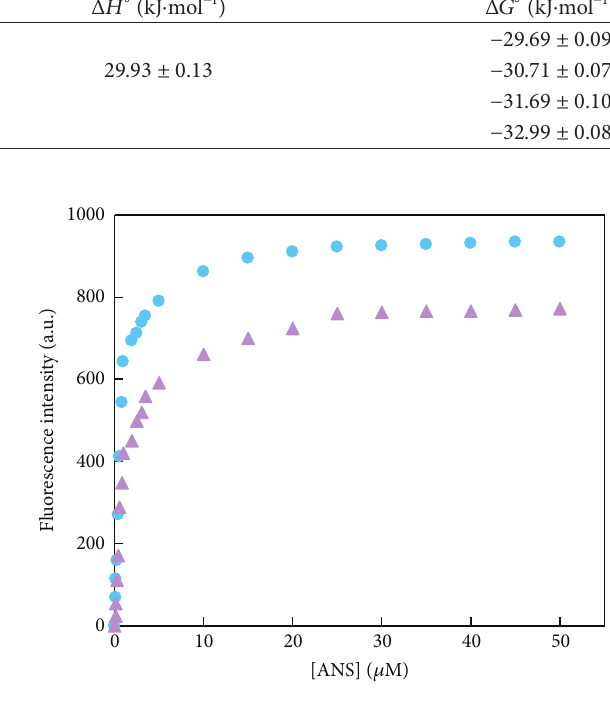
Figure 7: Binding of ANS to HSA (1 𝜇 M) in the absence ( ∙ ) and presence ( 󳵳 ) of 3 𝜇 M of